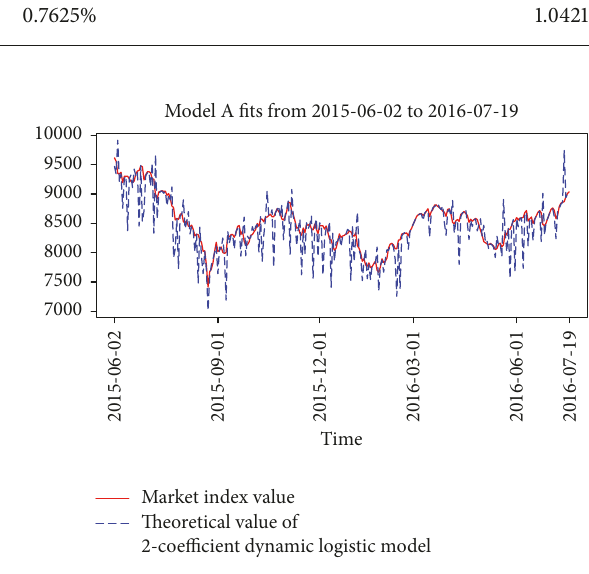
Figure 1: Time plot of raw data and model A